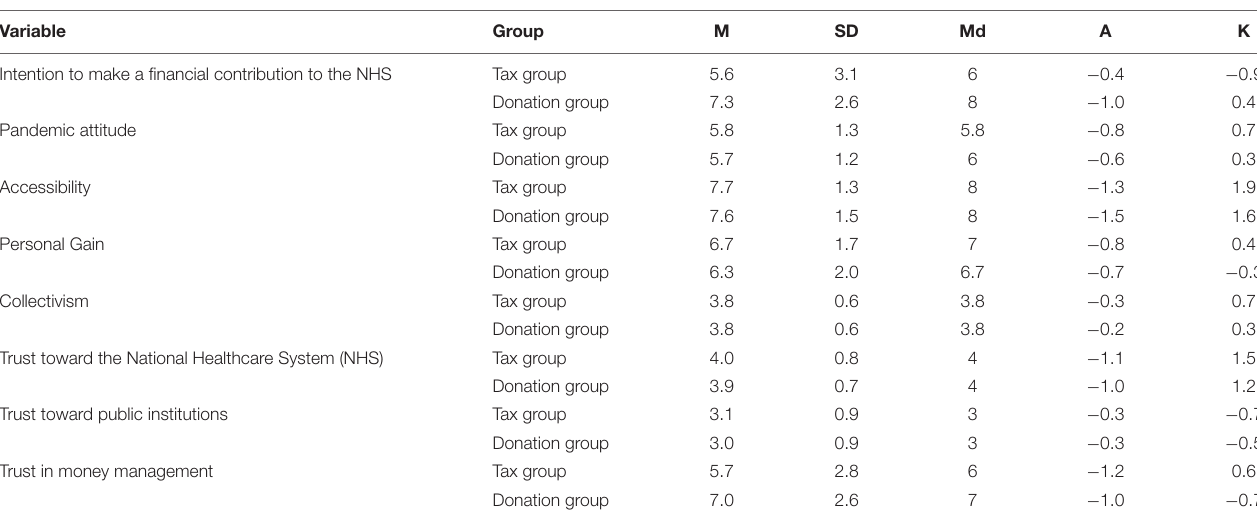
FIGURE 3 | Final model of relationships between antecedents and intention to make a financial contribution to the NHS (Tax group = 298; Donation group = 302). Standardized parameter estimates for the final model. *** p < 0.001; ** p < 0.01; * p < 0.05. TABLE 1 | Descriptive statistics for dependent and independent